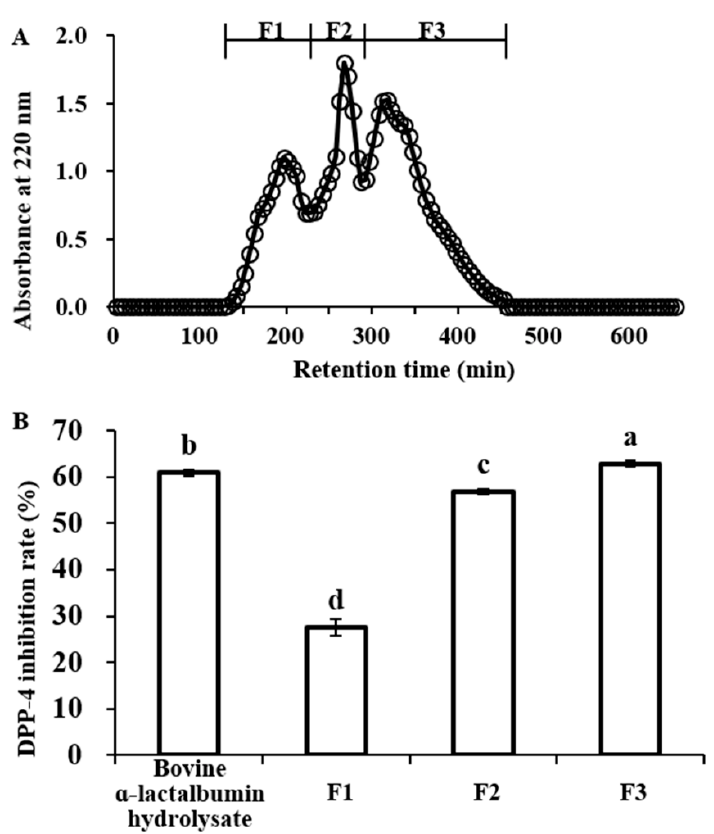
Figure 2. Elution profile ( A ) and dipeptidyl peptidase-IV (DPP-IV) inhibitory activity ( B ) of bovine α -lactalbumin hydrolysate fractions obtained by Sephadex G-25 gel filtration chromatography. The DPP-IV inhibition rate was determined using samples at concentration of 0.5 mg/mL (final assay concentration). Values are expressed as means ± SD of 3 independent determinations. Different letters indicate significant differences ( p < 0.05).